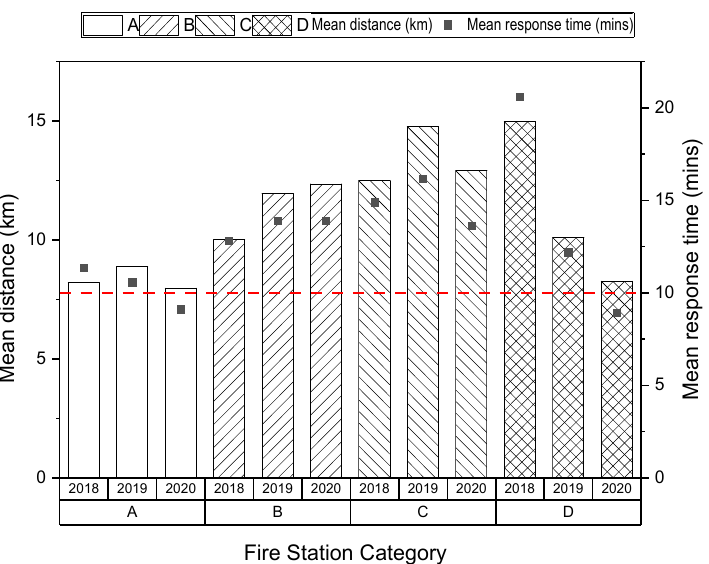
Figure 4. Mean distance travelled and mean response time by fire station category (A, B, C and D). The red dash line is the mean response time benchmark for Malaysia. Table 2. Summary of Pearson’s correlation analysis.